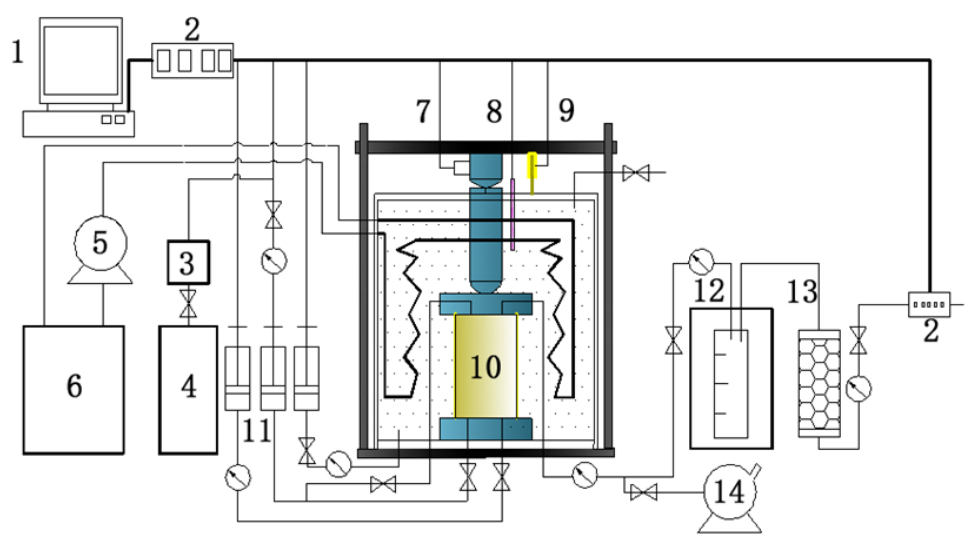
Figure 1. Schematic diagram of the tri-axial shear testing apparatus. (1) computer; (2) data acquisition system; (3) buffer tank; (4) methane gas bottle; (5) water pump; (6) thermal control pump; (7) stress transducer; (8) temperature sensor; (9) displacement transducer; (10) specimen; (11) syringe pump; (12) gas-liquid separator; (13) desiccant; (14) vacuum pump.